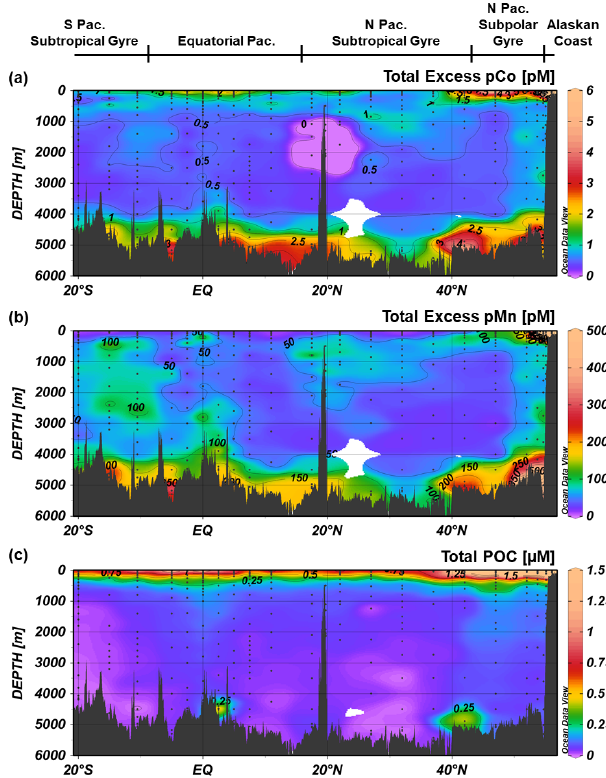
Figure 14. Total excess (lithogenically corrected) pCo (a) , total ex- cess (lithogenically corrected) pMn, (b) and total POC (c) transects along the GP15 cruise track. Total particulate values are summa- tions of the small particulate, total (SPT) and large particulate, total (LPT) size fractions. Weighted-average gridding is used to interpo- late between data